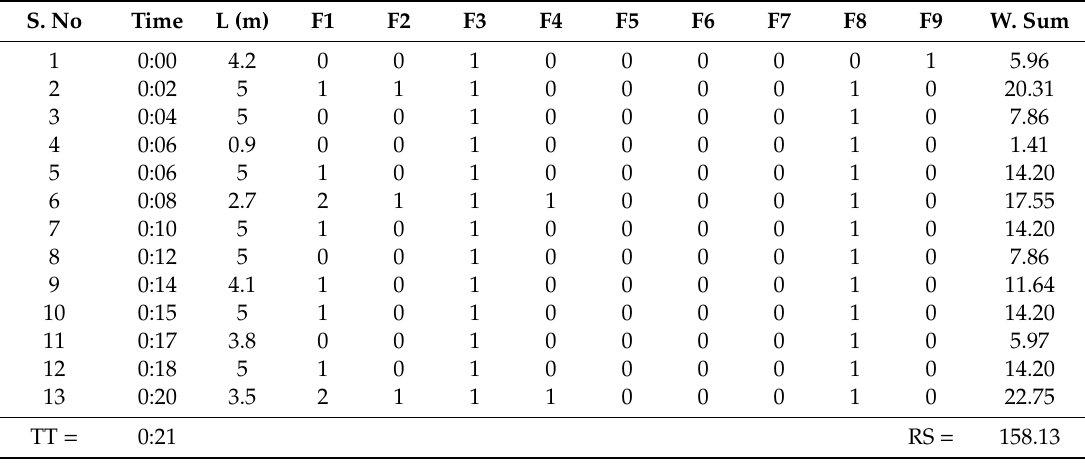
Table 8. RS calculation for Route 3 (in response to the second